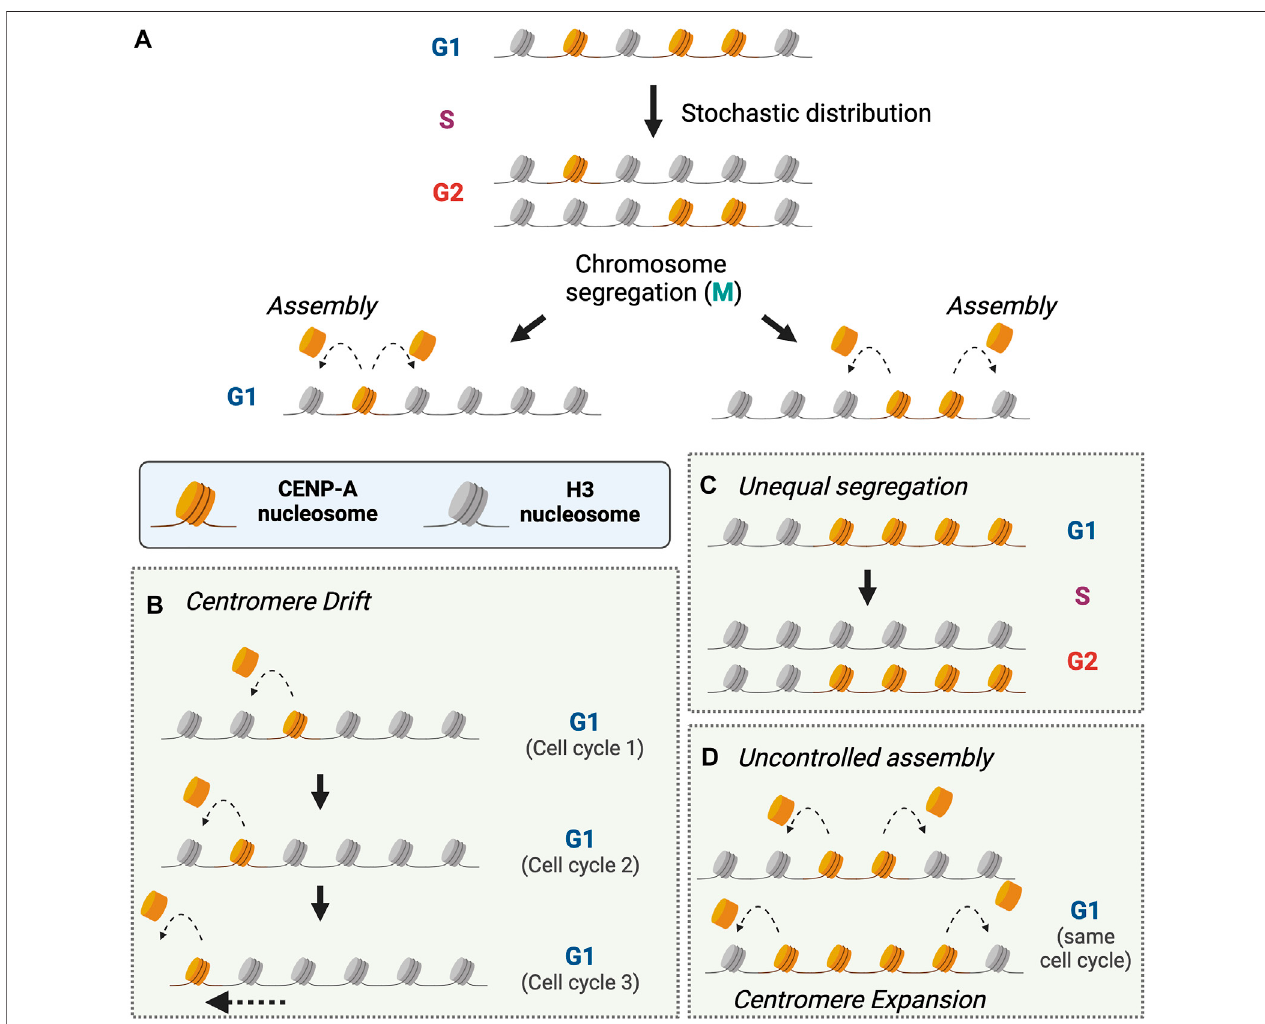
FIGURE 2 | Regulation of CENP-A segregation and assembly to maintain centromere identity. (A) . CENP-A nucleosomes are stochastically distributed to newly replicated chromosomes during DNA replication. During the next G1-phase, CENP-A nucleosomes that were distributed during replication promote the deposition of new CENP-A nucleosomes to replenish CENP-A at centromeres. Unregulated CENP-A deposition can result in loss of centromere identity within a few cell cycles as described in (B – D) . How cells prevent centromere drift, loss, or expansion is not explained by a CENP-A-templated assembly model. (B) . Assembly of CENP-A nucleosomes has the potential to allow drift of the centromere over multiple rounds of replication and assembly. (C) . Centromere expansion can occur due either to unequal segregation during replication or (D) . if multiple rounds of CENP-A nucleosome assembly can be directed by a single CENP-A nucleosome. (Created with